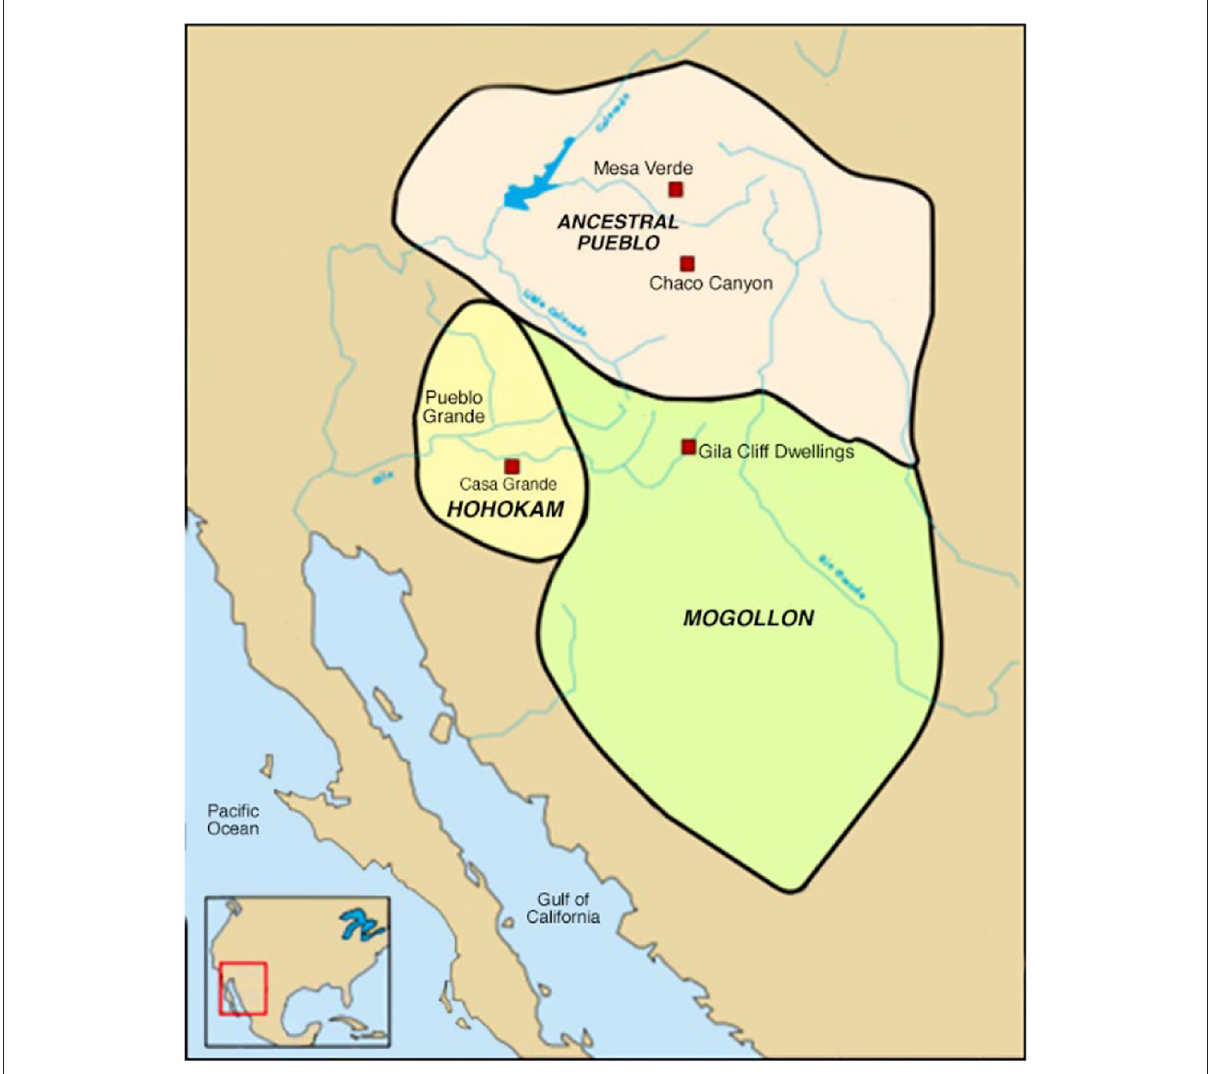
FIGURE2 Hohokam, Ancestral Pueblo, and Mogollon cultures circa 1350 CE (Source: Wikimedia Commons, 2015, https://commons.wikimedia.org/wiki/ File:Hohokam,_Ancestral_Pueblo,_and_Mogollon_cultures_circa_1350_CE.png, modified by Yuchitown. Creative Commons Attribution-Share Alike 4.0